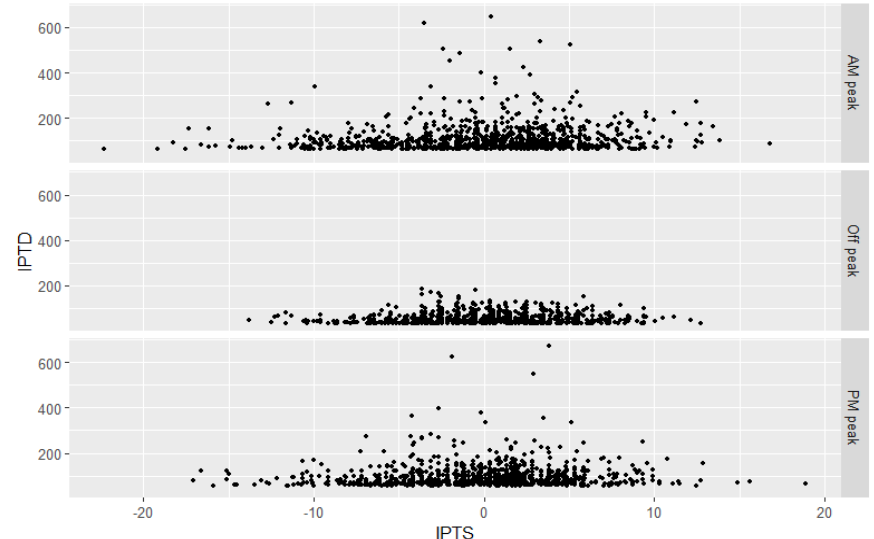
Figure 4. O-D-based IPTS and IPTD by time period